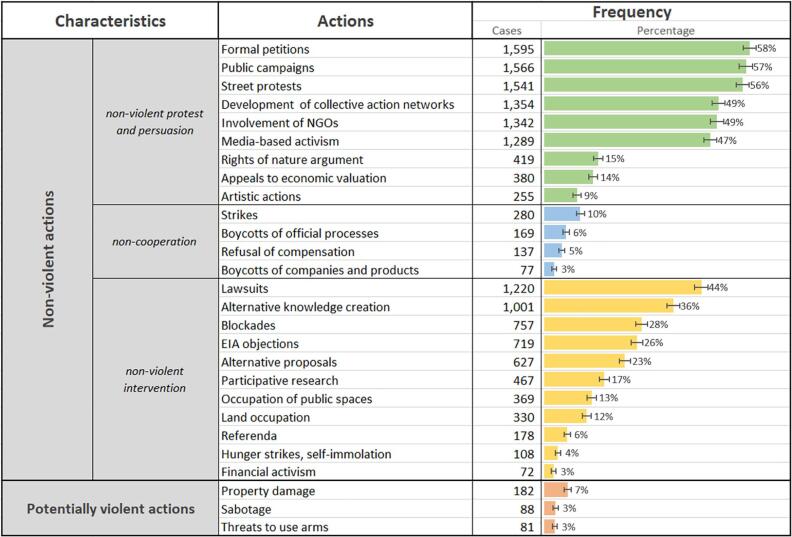
Characteristics of forms of mobilization and protest reported globally in the EJAtlas. Protest actions are clustered following Sharp (1973) (n = 2743). Error bars are 95% CIs.